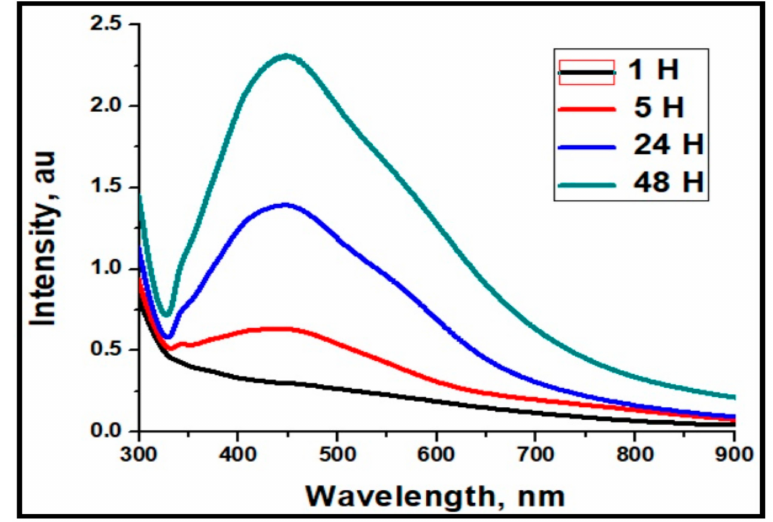
Figure 2. UV absorption spectra of alginate-capped Ag-NPs at di ff erent reaction